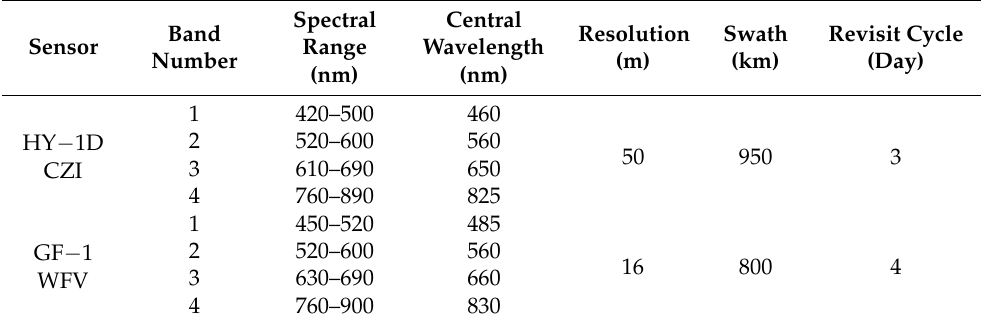
Table 1. Sensor characteristics of HY − 1D Coastal Zone Imager (CZI) and GF − 1 Wide Field of View (WFV).